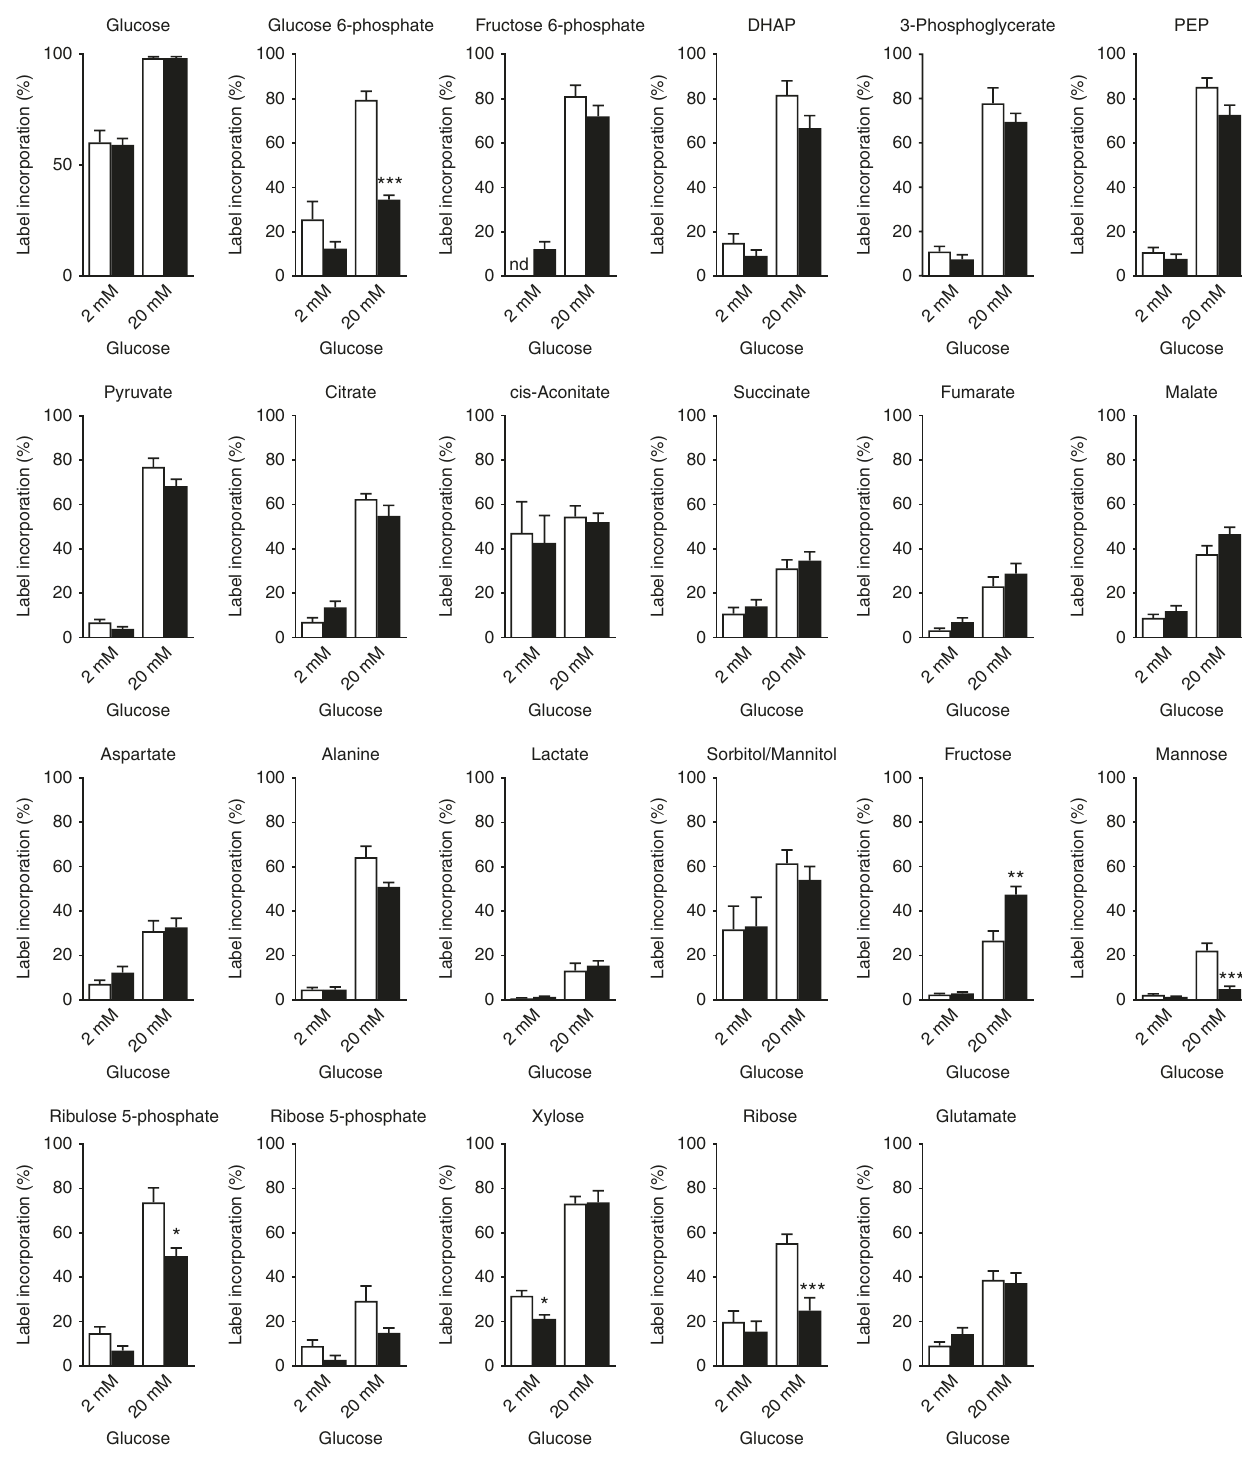
Fig. 8 Hyperglycaemia causes changes in [U- 13 C]-glucose labelling. Percentage of label incorporation of the indicated metabolites in INS-1 cells cultured at 5 mM (white) or 25 mM (black) glucose and then challenged with 2 or 20 mM [U- 13 C]-glucose for 30 min. Label incorporation is de fi ned as the proportion of molecules in a metabolite pool containing one or more 13 C atoms. DHAP, dihydroxyacetone phosphate. PEP, phosphenolpyruvate. Data show mean ± s.e. m. (where from left to right for each metabolite, n = 13, 13, 19 and 18). One-way analysis of variance and Bonferroni-corrected Welch ’ s t test. * p < 0.05, ** p < 0.01,*** p < 0.001, nd not